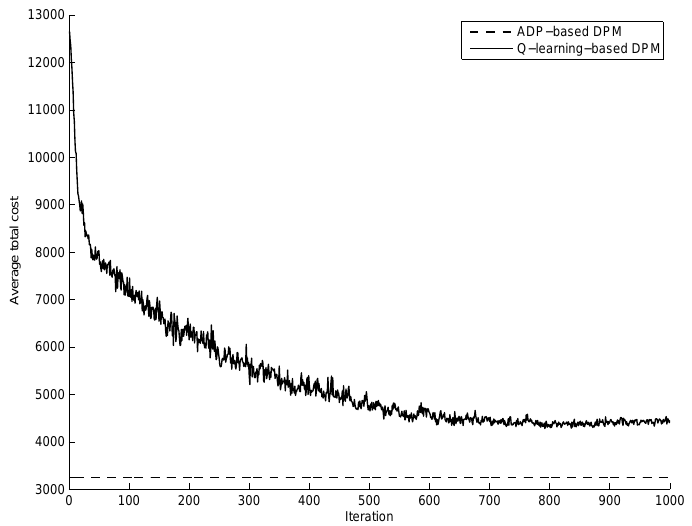
Figure 4. Charge-depleting patterns of the battery and supercapacitors resulting from the Q-learning-based DPM.